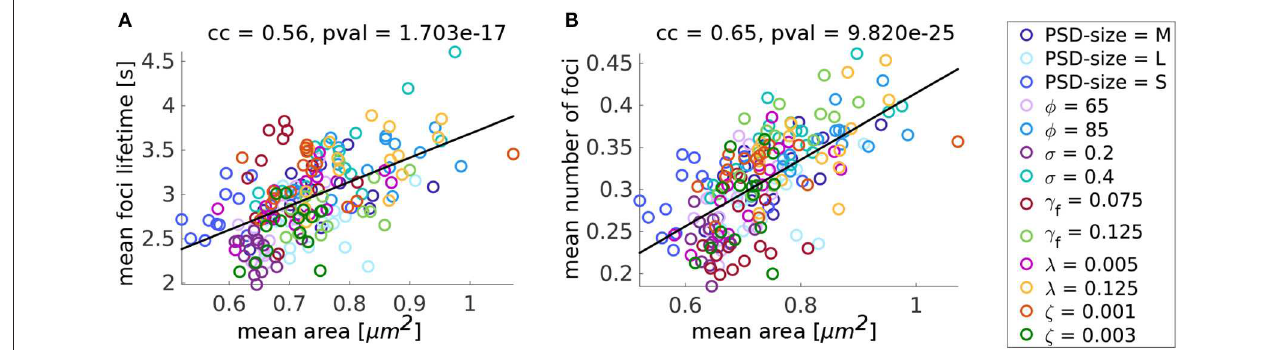
FIGURE 10 | Summary of the parameter variation simulations. (A) Mean focus lifetime over mean spine area for different parameter variations. Each dot represents one simulation with a parameter variation corresponding to its color. Standard values of the parameters are reported in Table 1 . For every variation of a parameter 15 simulations of 15 min were performed. cc denotes the linear correlation coefficient and pval is the p -value for testing the hypothesis of no correlation against the alternative hypothesis of a non-zero correlation, using Pearson’s Linear correlation coefficient. (B) Same for mean number of foci over mean area.